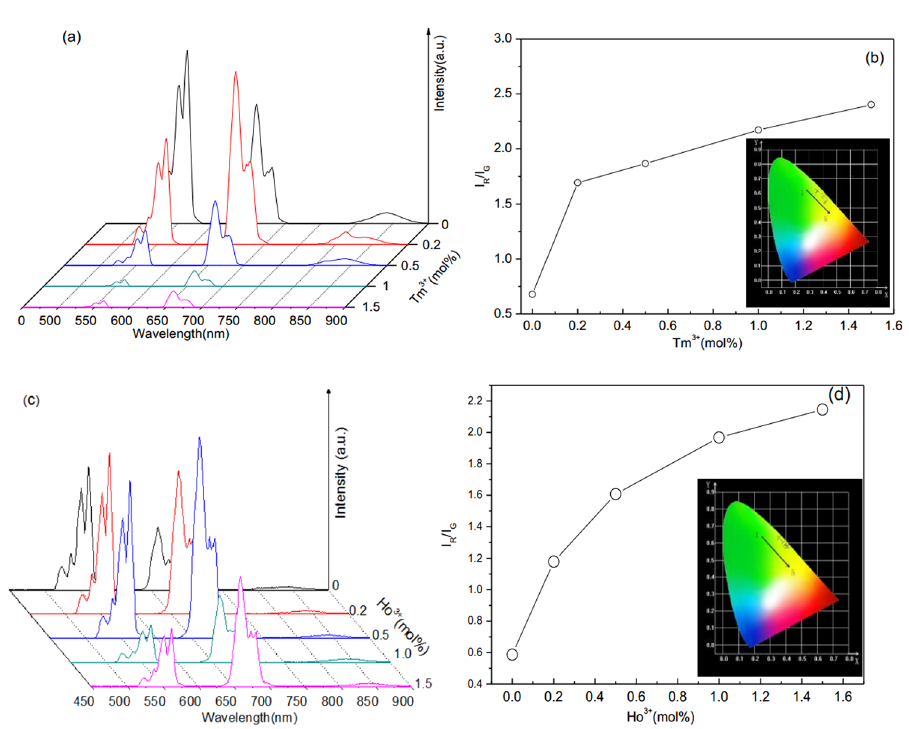
Figure 3. ( a ) Emission spectra, ( b ) red to green intensity ratio and CIE (X, Y) chromaticity coordinates diagram of 1%Er 3 + , x%Tm 3 + co-doped Y 2 O 3 (x = 0, 0.2, 0.5, 1, 1.5). ( c ) Emission spectra and ( d ) Red to green intensity ratio and CIE (X, Y) chromaticity coordinates diagram of 1%Er 3 + , x%Ho 3 + co-doped Y 2 O 3 (x = 0, 0.2, 0.5, 1,